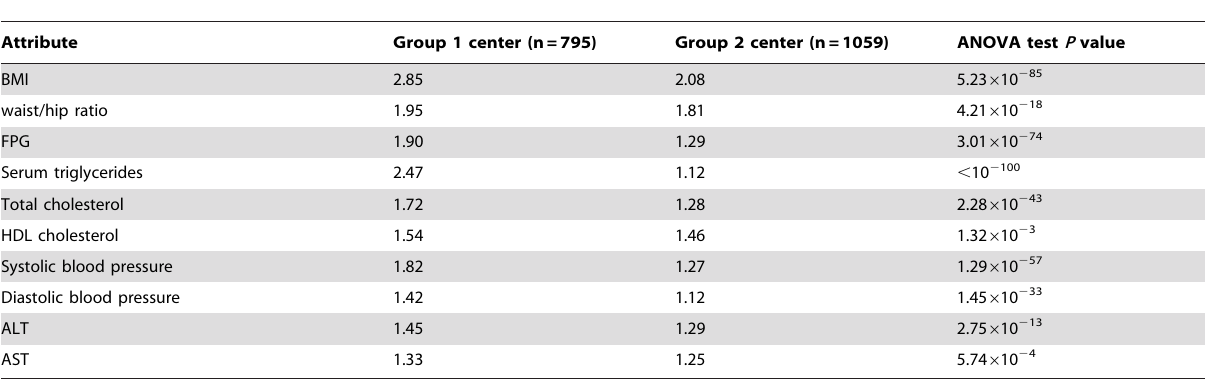
Table 1. K-means classification of the 1854 individuals a